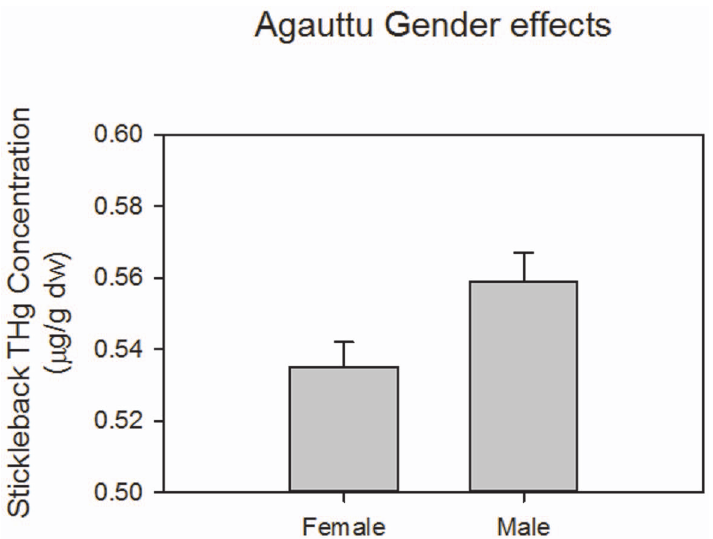
Figure 3. Total mercury (THg) concentrations in female and male threespine stickleback collected at two lakes at Agattu Island, Aleutian Archipelago, Alaska, 2011. Concentrations are reported as back-transformed least square means from the global mixed-effects model which accounts for other variables. Error bars represent 6 SE.